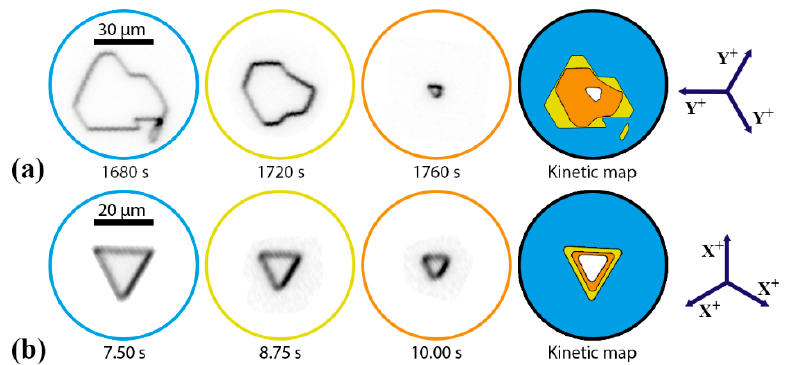
Figure 9. The domain shrinkage stage. The domain wall images and kinetic maps: ( a ) transformation of the polygonal domain shapes at E ex = 3.75 kV/mm, and ( b ) evolution of the formed rotated triangular domain with slow Y − walls at E ex = 11.25 kV/mm.